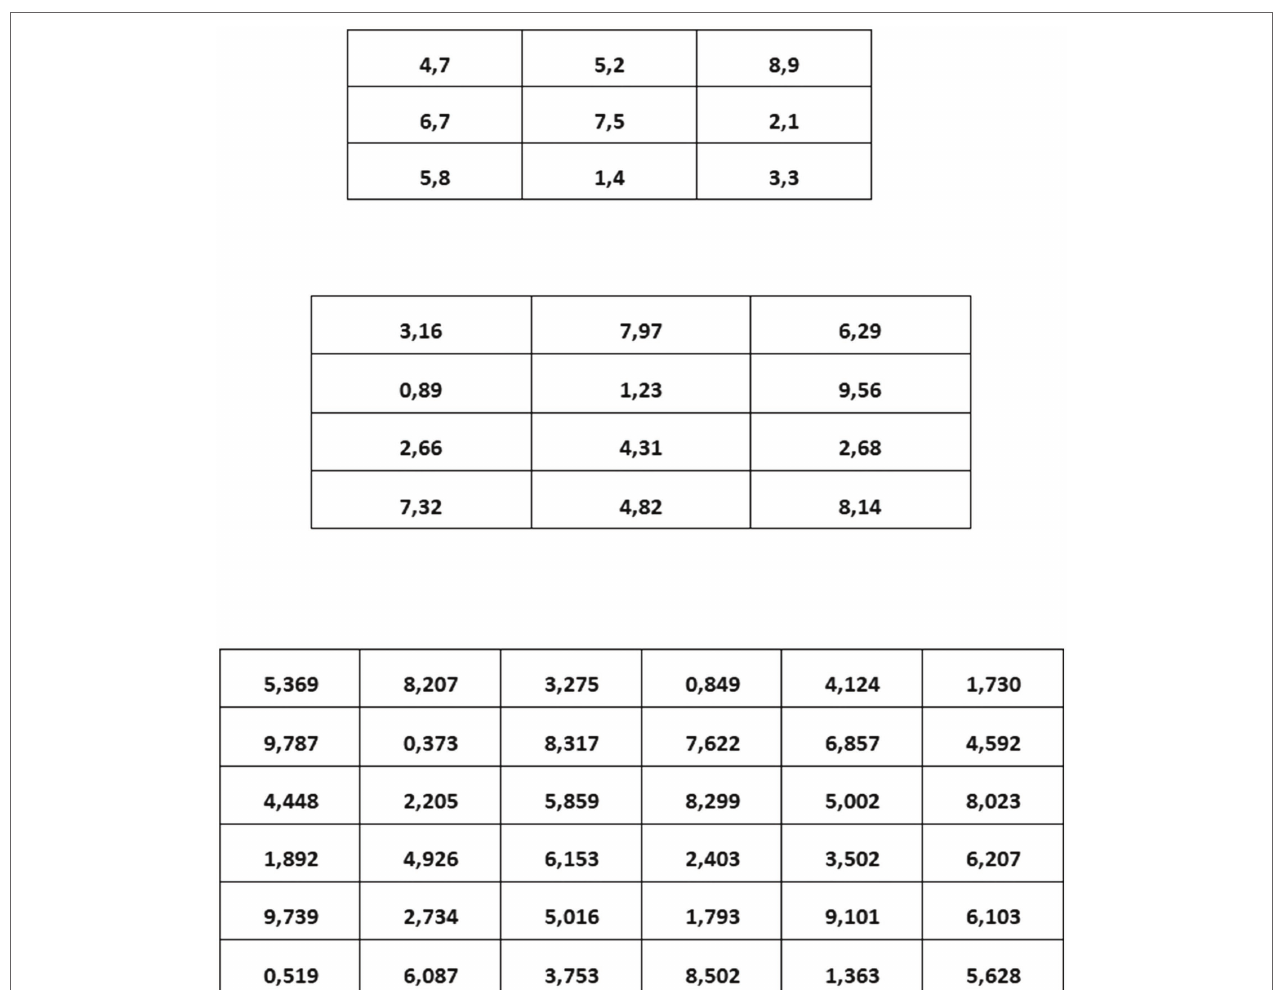
FIGURE 2 | Examples for easy (top panel), medium (middle panel), and difficult (bottom panel) matrices in the “adding-to-ten”